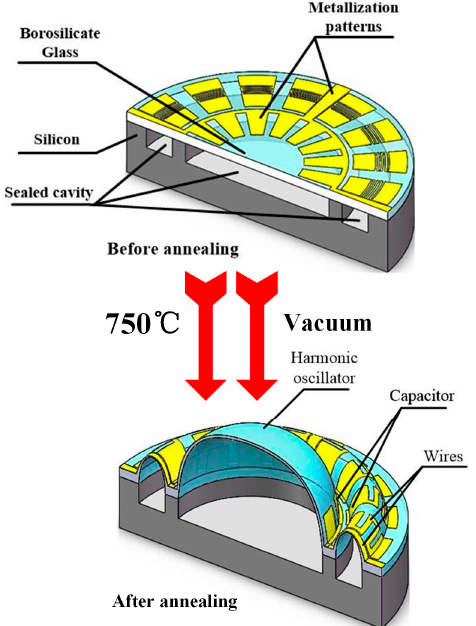
Figure 2. Schematic diagram of glassblowing process and metallization patterns used to form capacitors.